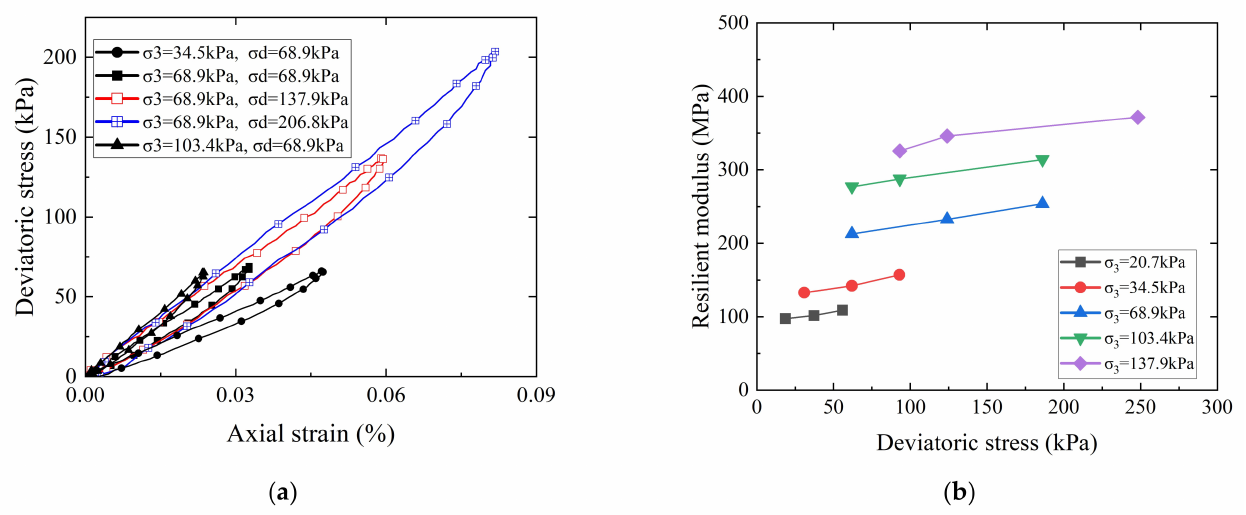
Figure 12. Effects of different stress states on the resilient modulus of recycled BDW aggregates: ( a ) Hysteresis curves of the deviator stress versus axial strain. ( b ) The resilient modulus versus deviator